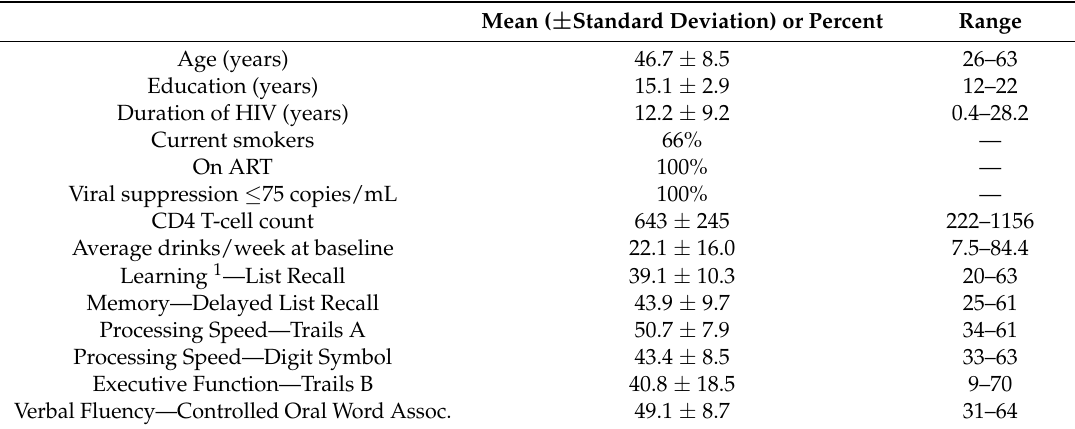
Table 1. Baseline participant demographic and clinical characteristics ( N =